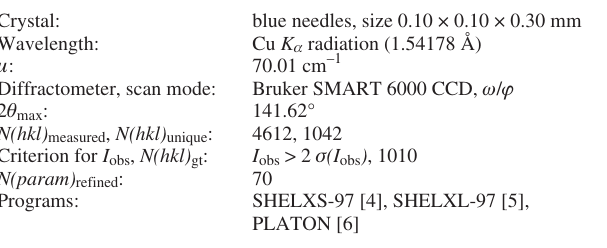
Table 1. Data collection and handling.